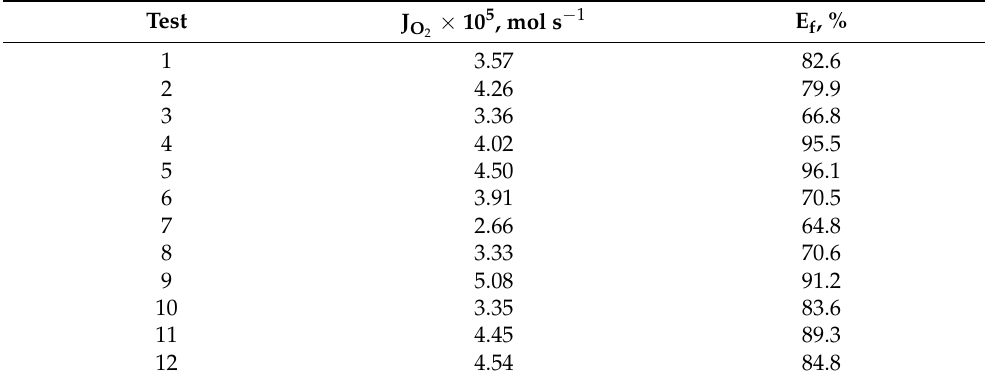
Table 5. Oxygen consumption rate and efficiency for molten white metal conversion experiments.